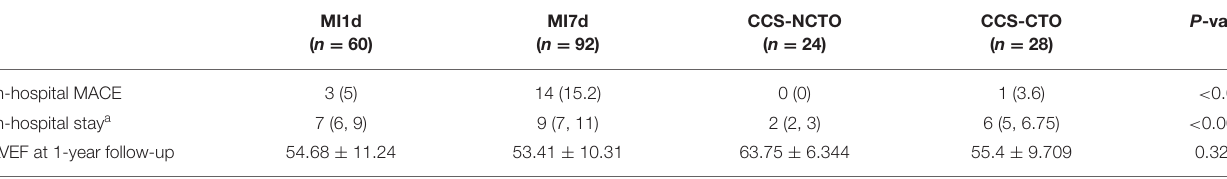
TABLE 5 | In-hospital outcomes and LVEF at 1-year follow-up in the four groups.